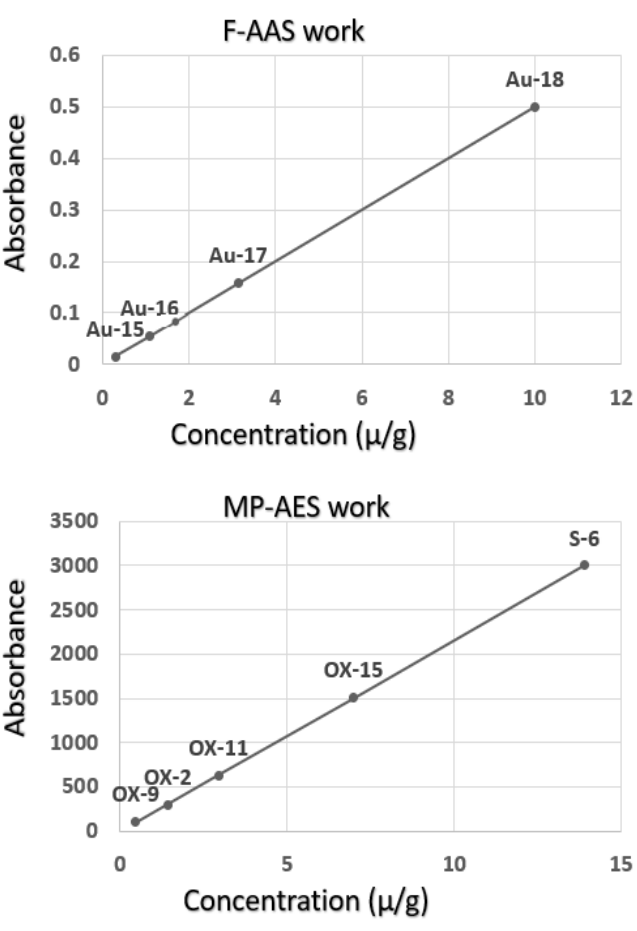
Figure 2. Calibration curves for Au with matrix-matching reference materials of different concen- trations. Samples and calibration solutions were diluted in a similar way and the concentration calculation was straightforward [65,66].